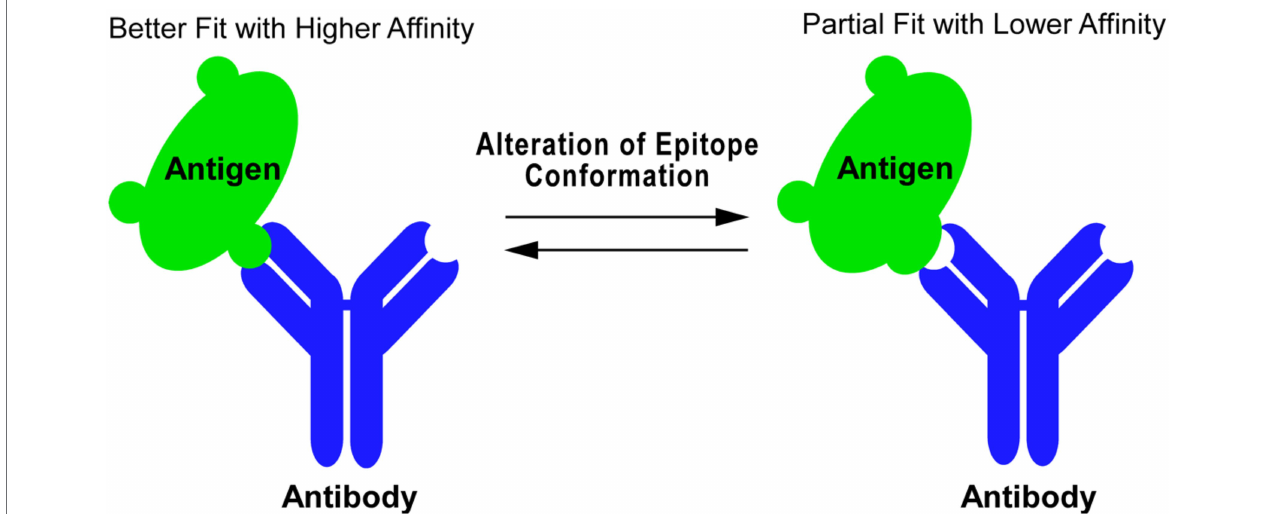
FIGURE 1 | Antibody as probe to detect protein conformational change. Antibody–antigen binding is a protein–protein interaction whose affinity is determined by 3-D structural fitting of the antigenic epitope and the variable region of antibody. Changes in the epitope conformation can be reflected in the antibody binding affinity, where an alteration of the epitope conformation can shift an antibody–antigen interaction from a better fit with higher affinity (left) to a partial fit with lower affinity (right) and vice versa.